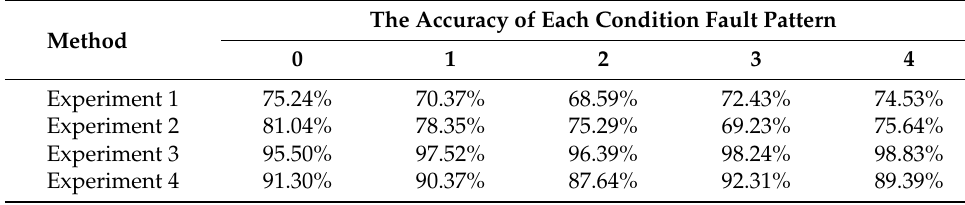
Table 7. Results of trimed model